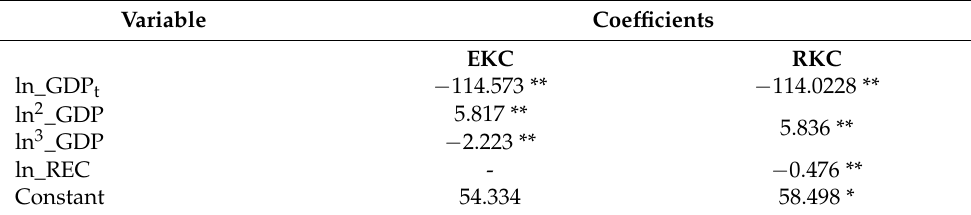
Table 6. Pesaran common correlated effects estimators in basic EKC and RKC for V4 and Baltic countries 1 .